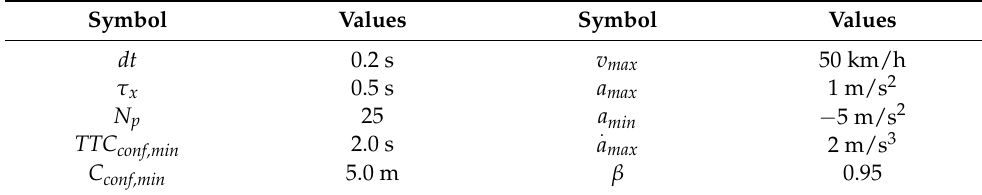
Table 1. Parameters for SMPC